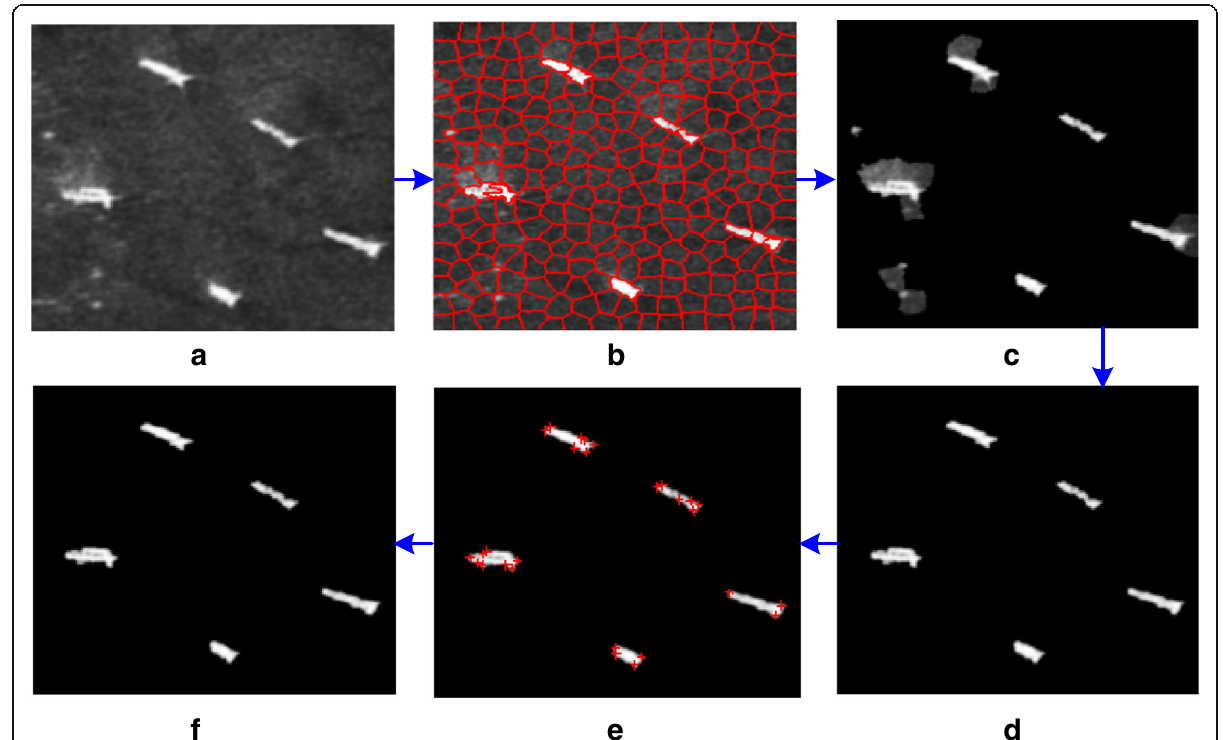
Fig. 10 The detection result of the SAR image without land area. a The original SAR image. b Superpixel segmentation result. c The candidate superpixel patches. d The weighted entropy filtering result. e Harris corner detection result. f The final detection